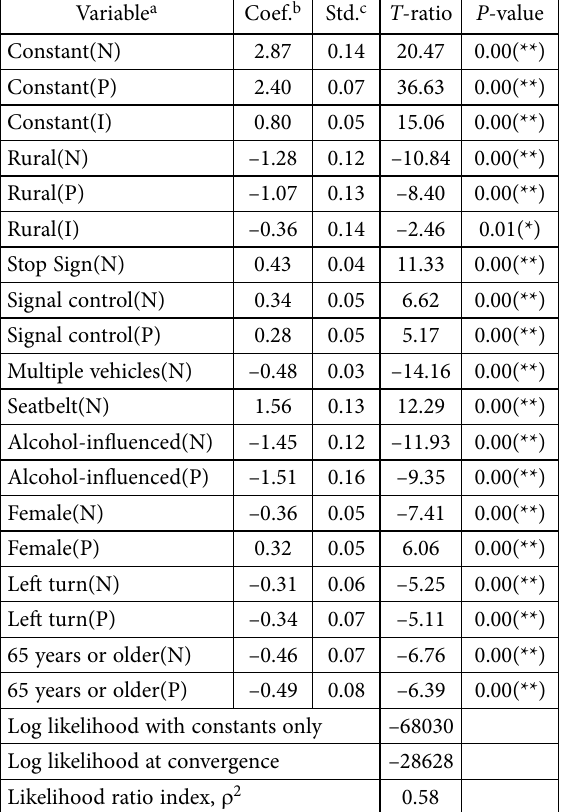
Table 2. Driver’s injury severity model estimation